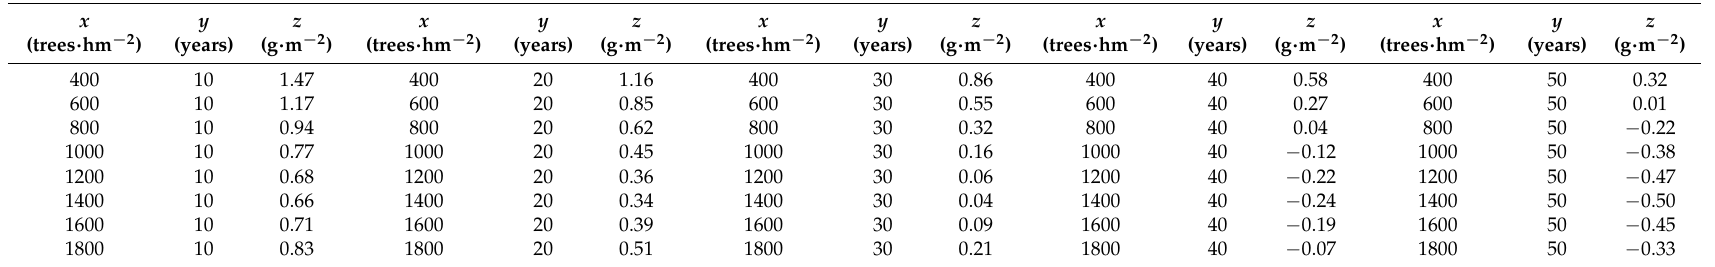
Table 2. Daily sand transport rates under the different poplar stand densities and age combinations in Zhangbei County, Hebei Province,